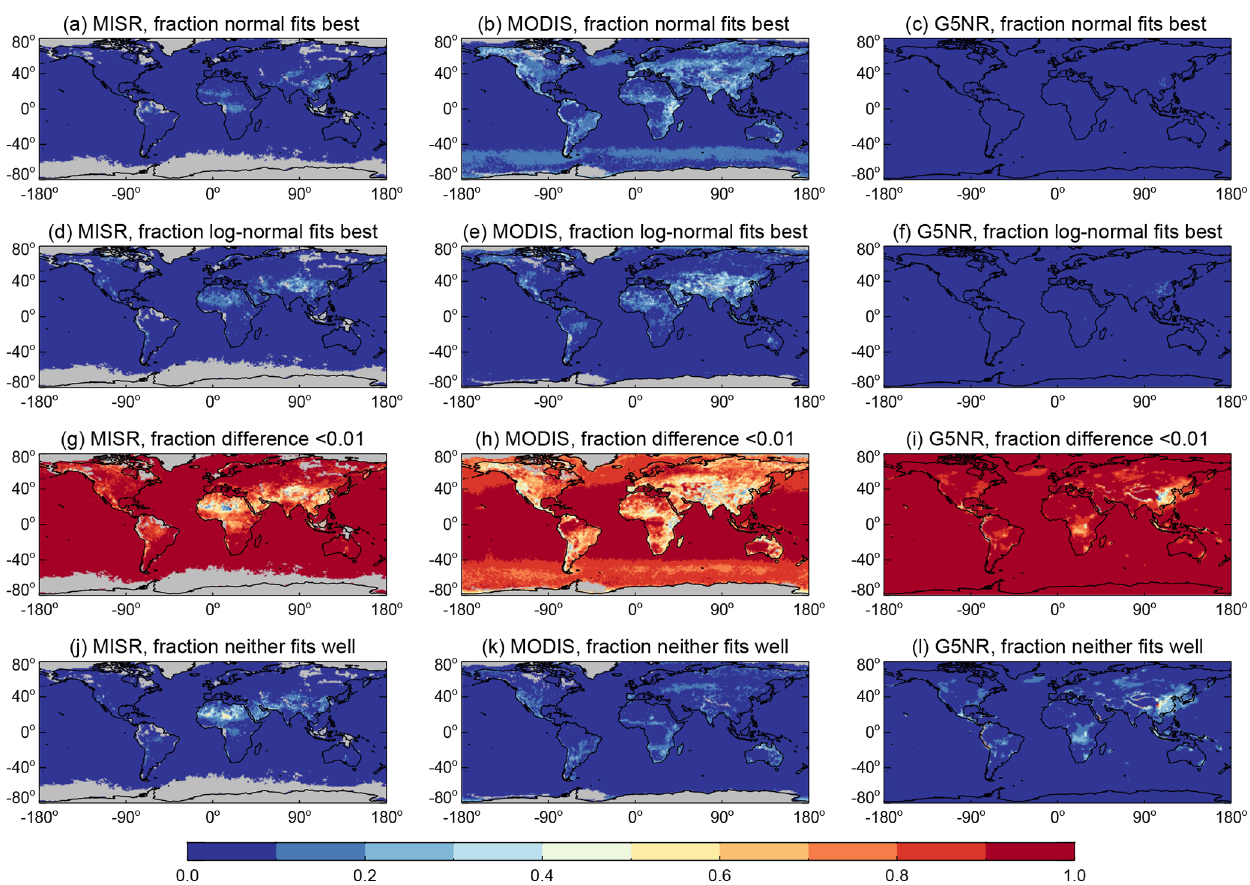
Figure 4. As in Fig. 3 except for AOD distributions aggregated spatially from full resolution to 1 ◦ , considering data collected on individual days. Columns show (left) MISR, (middle) MODIS, and (right) G5NR data. At least 50 contributing days are required for a grid cell to be valid; grid cells with insufficient data are shaded in